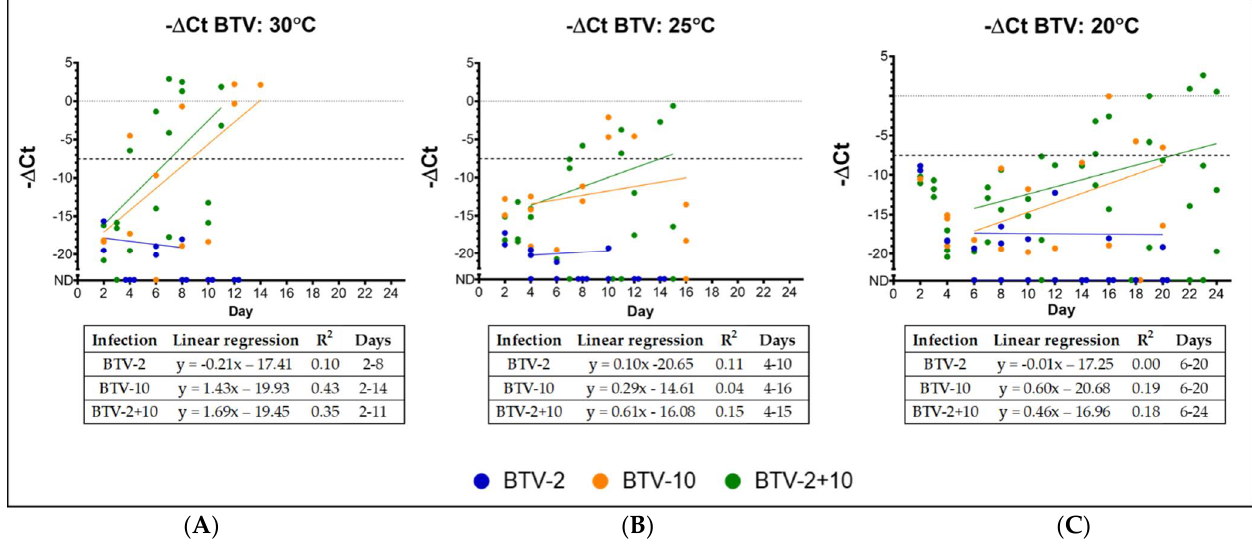
Figure 2. BTV virogenesis in midges held at 30, 25, and 20 °C. Each point indicates a single pool of Culicoides , and ΔCt values are presented. ΔCt is calculated as the difference between mean BTV Ct values and cox 1 Ct values for each sample. To make graphs more intuitive, −ΔCt values are presented. BTV-2 samples are represented in blue; BTV-10 samples are represented in orange; BTV-2+10 samples are represented in green. The dashed line indicates mean post-blood meal day 0 ΔCt across all infection groups (BTV-2, BTV-10, and BTV-2+10). Points depicted at “ND” (not detected) indicate undetectable BTV Ct values and were not included in linear regressions. ( A ) BTV virogenesis in midges held at 30 °C: BTV virogenesis is evident in pools of C. sonorensis exposed to BTV-10 and BTV-2+10 at 4 days after blood meal when held at 30 °C. BTV-2 remains near undetectable limits across all days. ( B ) BTV virogenesis in midges held at 25 °C: BTV virogenesis is evident in pools of C. sonorensis exposed to BTV-10 and BTV-2+10 at 7– 8 days after blood meal when held at 25 °C. BTV-2 remains near undetectable limits across all days. ( C ) BTV virogenesis in midges held at 20 °C: BTV virogenesis is evident in pools of C. sonorensis exposed to BTV-10 and BTV-2+10 at ~15 days after blood meal when held at 20 °C. BTV-2 remains near undetectable limits across all days. Please see the table within each figure for more details regarding regression analysis.